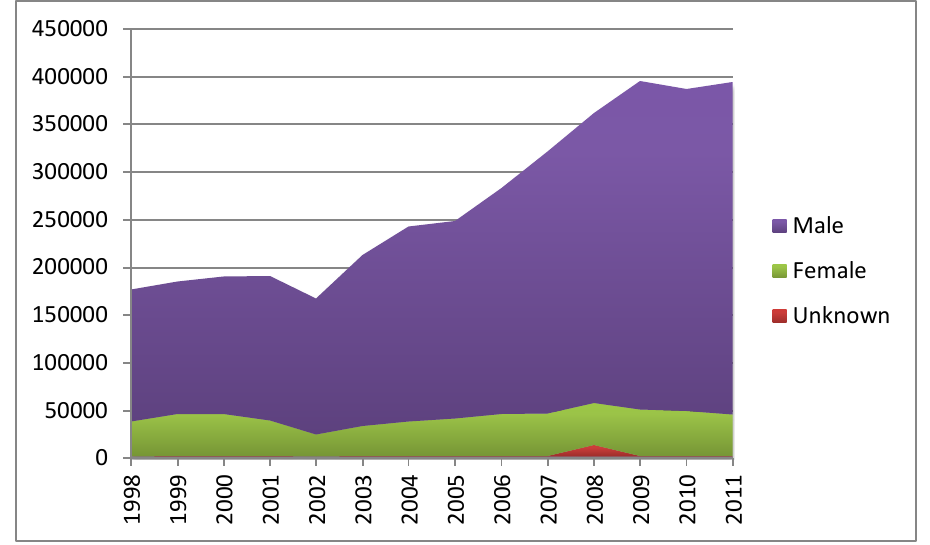
Figure 2: DHS Removals by Sex: Fiscal Years 1998 to